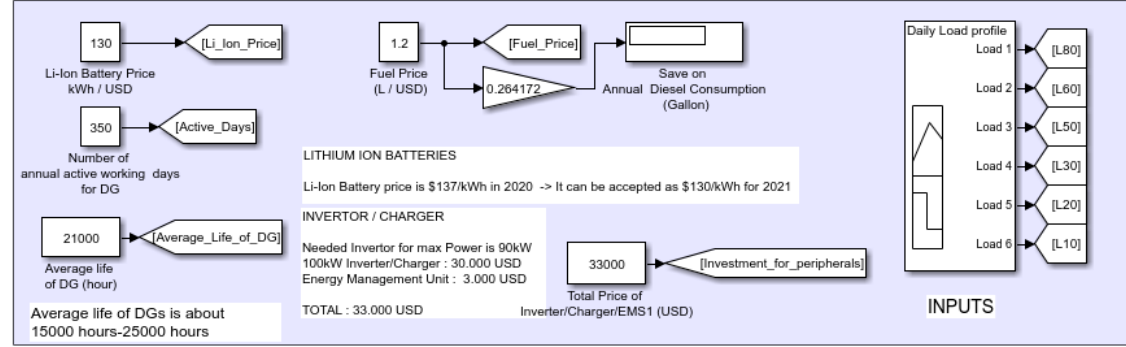
Figure 2. Inputs block.